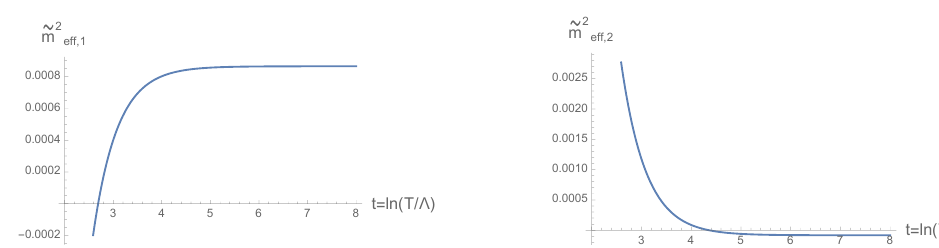
Figure 13. Plots of the rescaled effective masses (squared) against t = ln( T/ Λ) for r = 0 . 1 , θ = 2 . 1 , λ = 0 . 001 , c 1 = 0 , c 2 = − 0 . 1 :